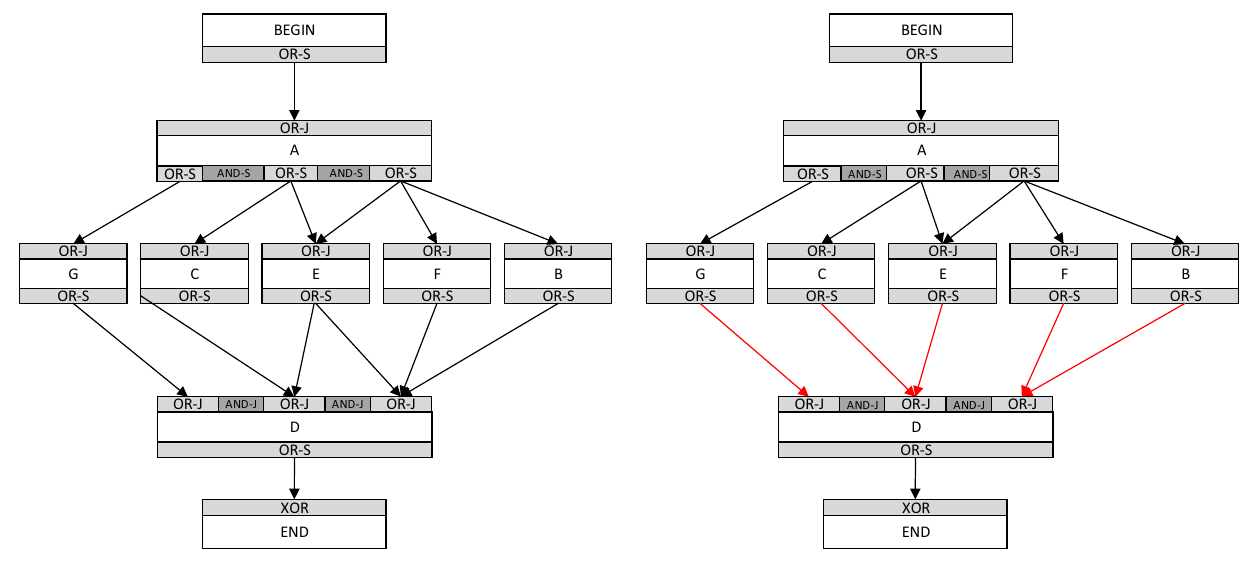
Fig. 7 The original process model of a7 (left) and the obtained process model of a7 (right) Table 5 Comparing PSOMiner with three state-of-the-art algorithms on event logs with 10% noise Event